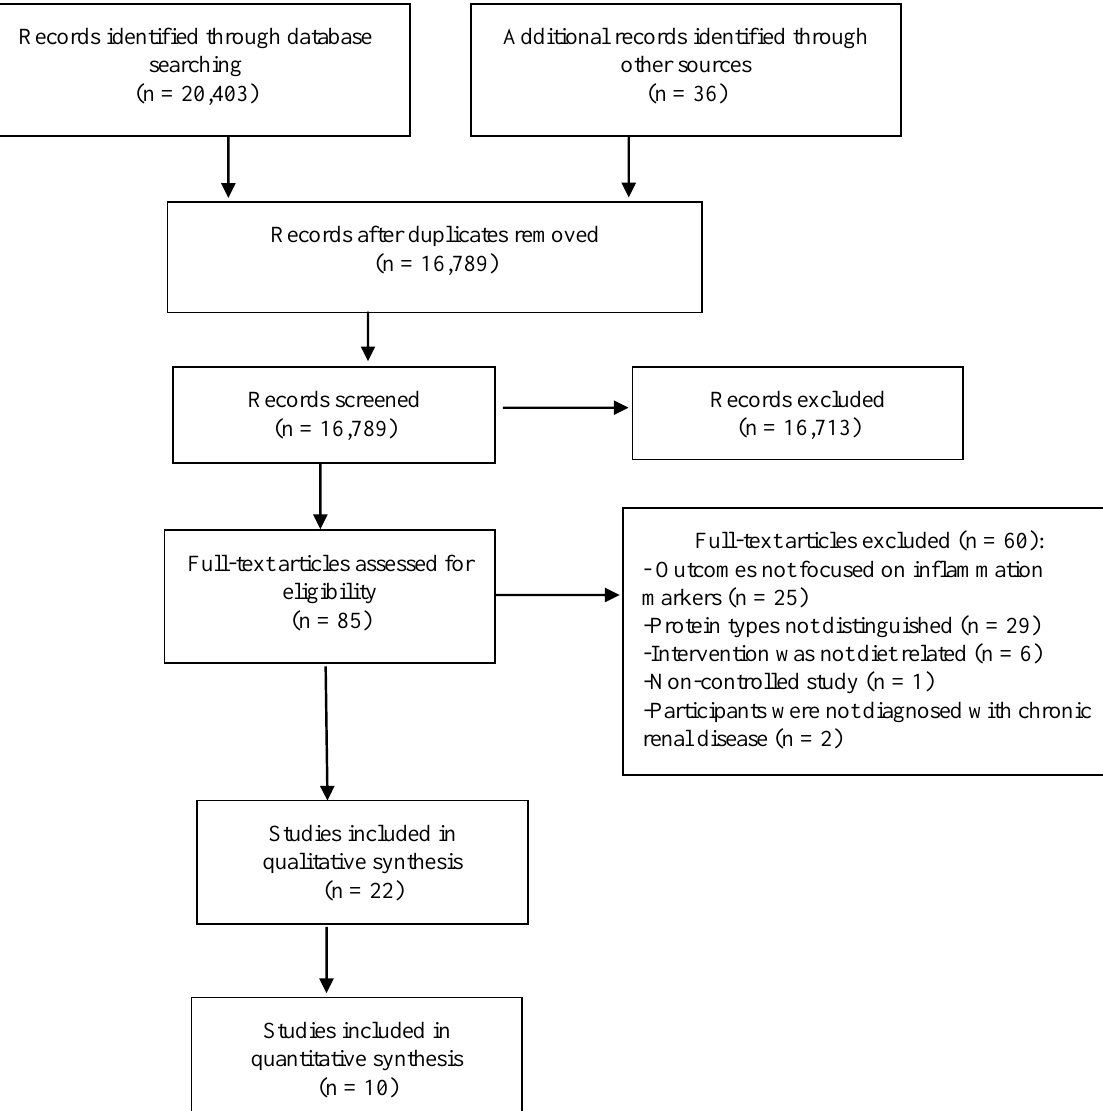
Figure 1. PRISMA flow diagram showing the screening